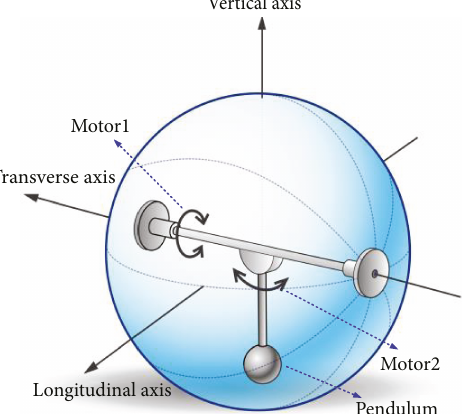
Figure 1: Mechanical schematic of a 2-DOF pendulum-based spherical robot.